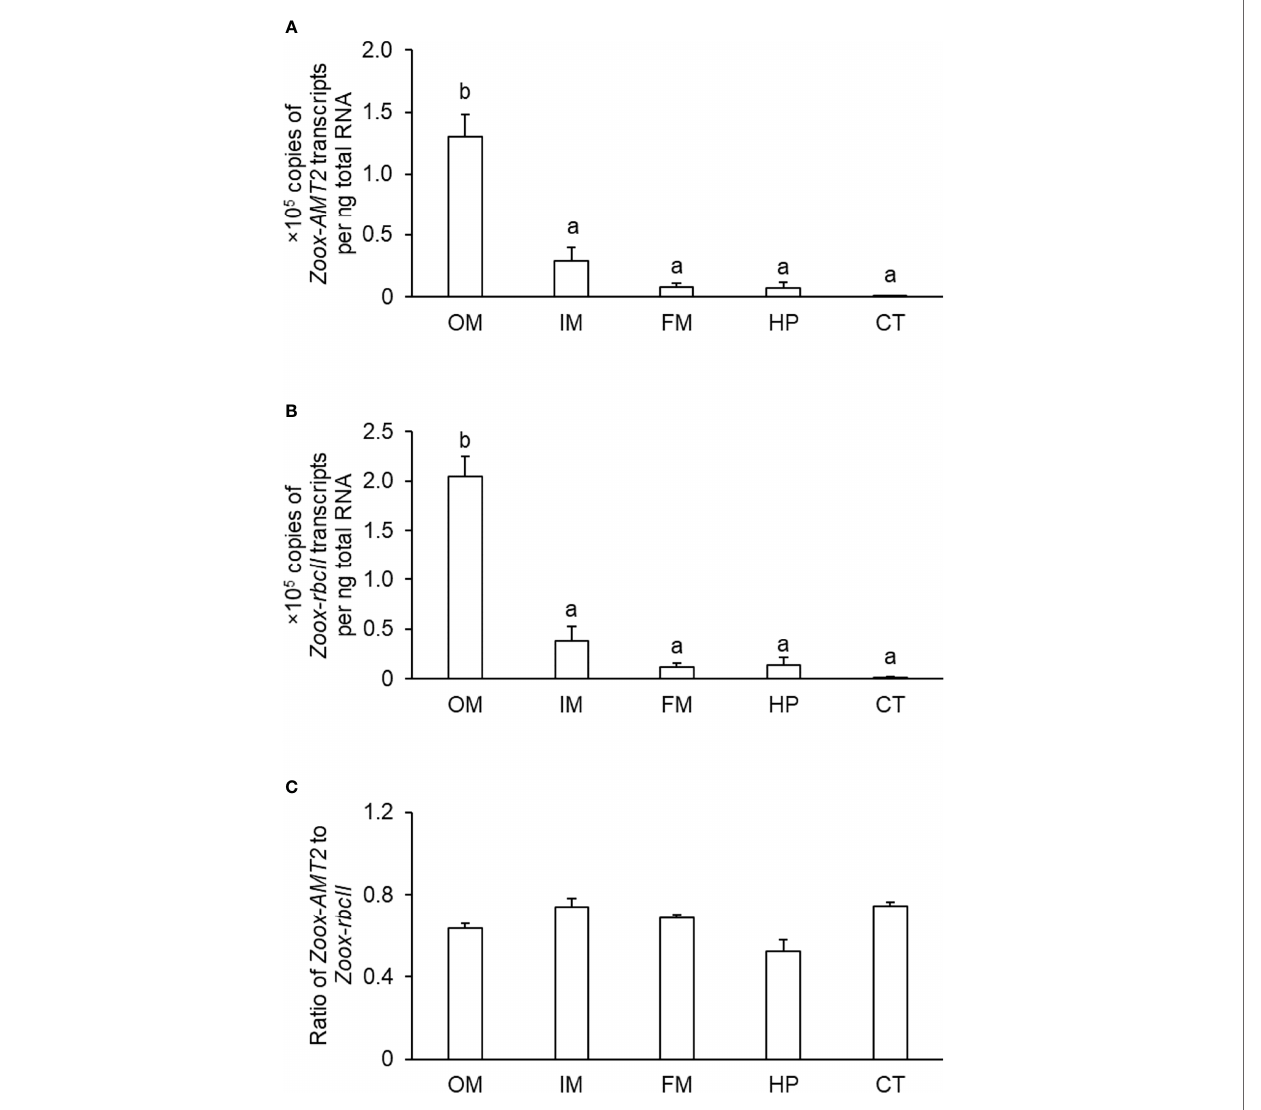
FIGURE 3 | Transcript levels (×10 5 copies of transcript per ng total RNA) of (A) zooxanthellae-ammonium transporter 2 ( Zoox-AMT2 ) and (B) zooxanthellae-form II ribulose-1,5-bisphosphate carboxylase/oxygenase ( Zoox-rbcII ), and the (C) transcript ratio of Zoox-AMT2 / Zoox-rbcII in the outer mantle (OM), inner mantle (IM), foot muscle (FM), hepatopancreas (HP) and ctenidium (CT) of Tridacna squamosa . Results represent means + SEM. (n = 4). Means not sharing the same letter are signi fi cantly different (p-value < 0.05 for transcript levels using ANOVA or p-value < 0.01 for transcript